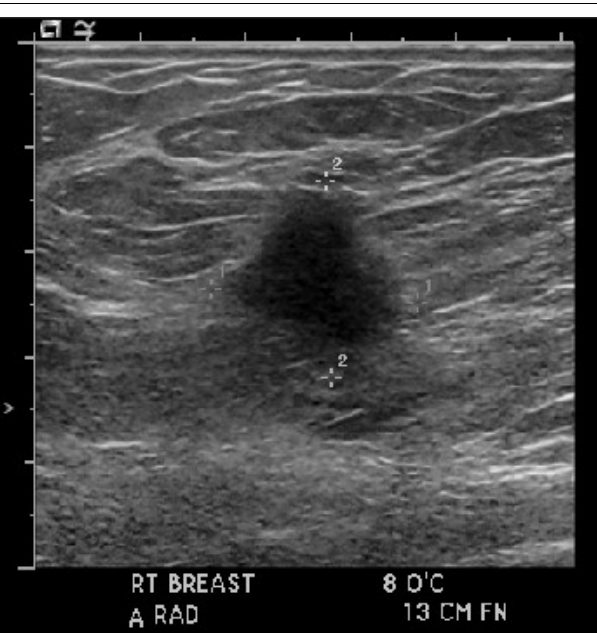
Figure 2: Ultrasound Image Showing Right Breast Mass Prior to Biopsy.